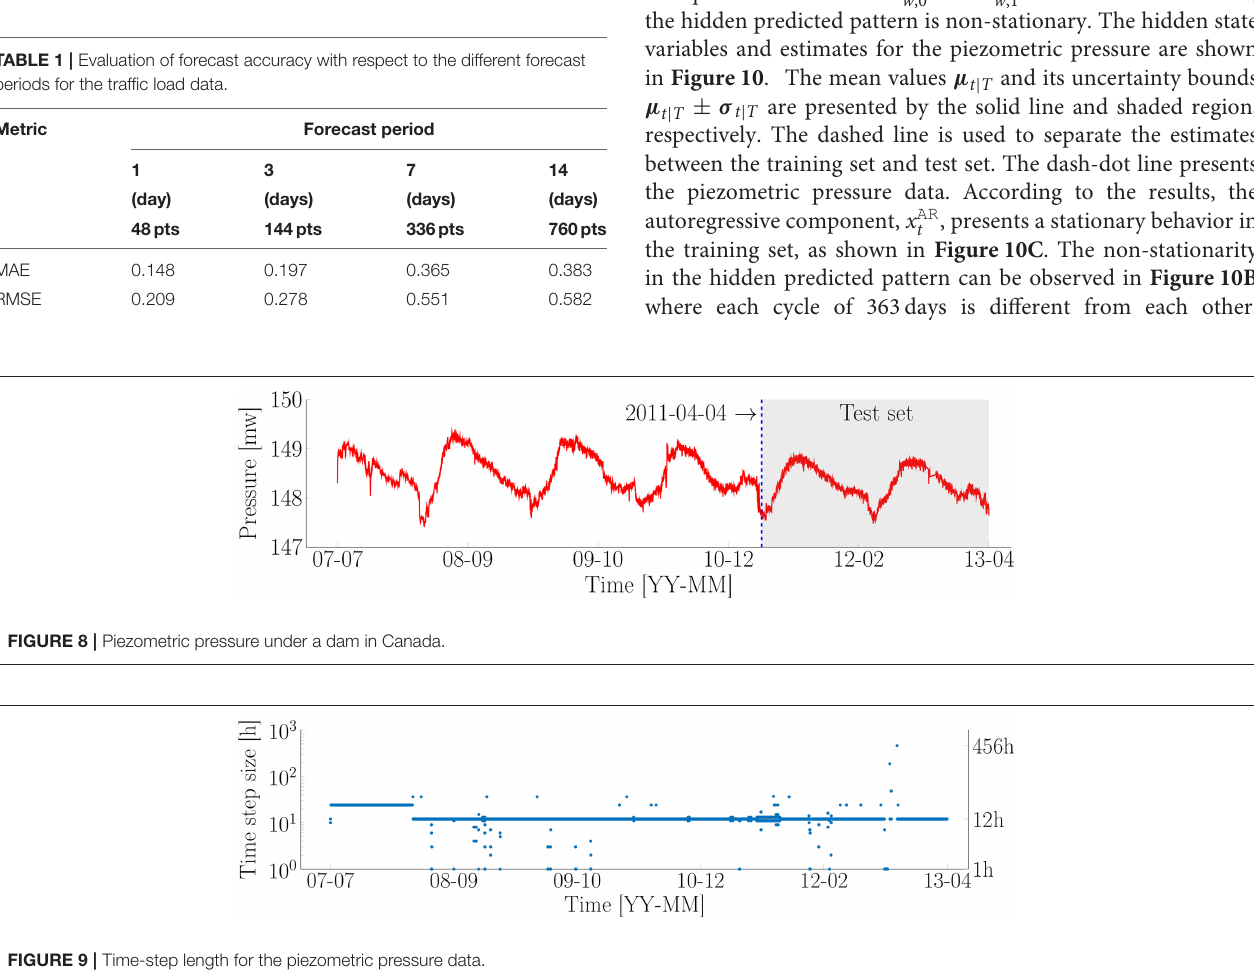
Frontiers in Built Environment |